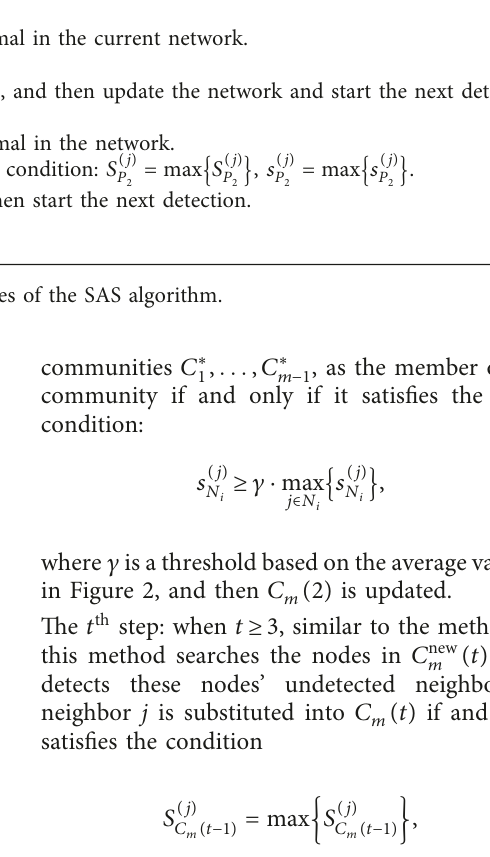
Algorithm community detection with self-adapting